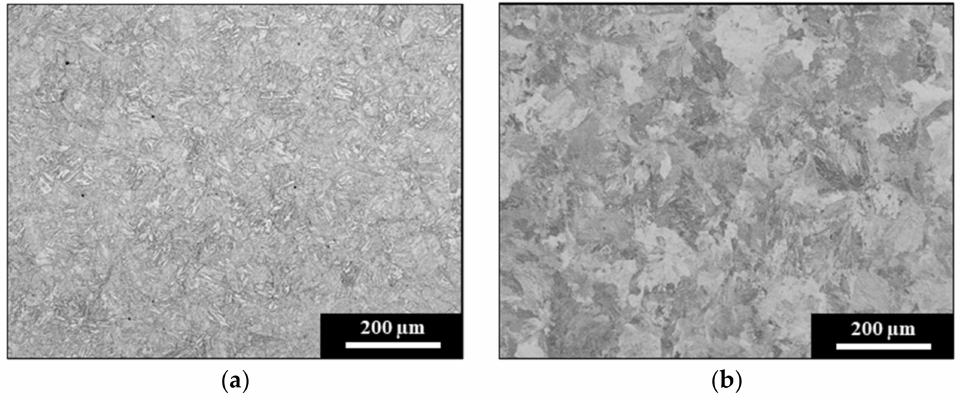
Figure 3. ( a ) Tempered martensitic microstructure of light rail, and ( b ) pearlitic microstructure of hypereutectoid